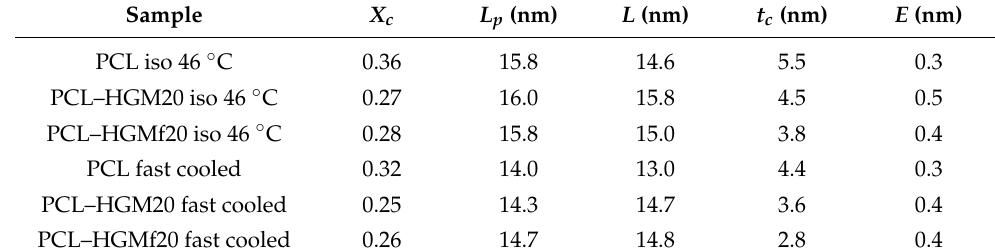
Table 3. Structural and supermolecular parameters of pure PCL and composites.